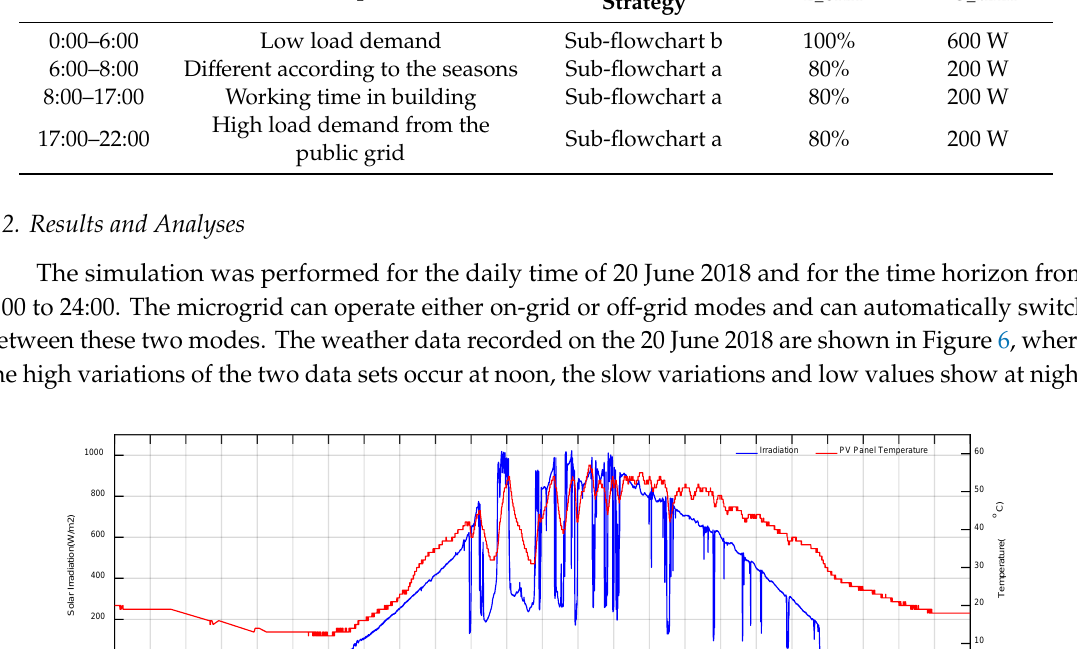
( b ) Figure 7. Curves of common DC bus voltage and state of charge (SOC) of storage ( a ) and curves of power ( b ).